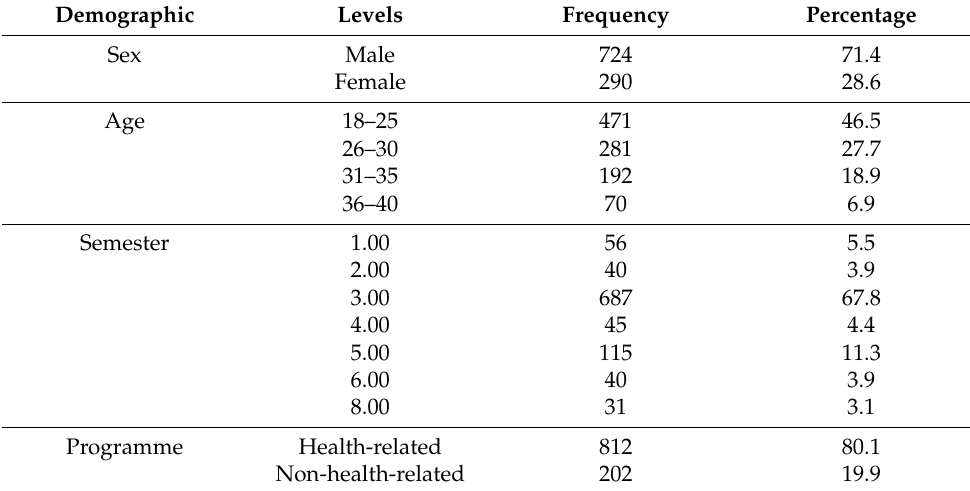
Table 1. Demographic Characteristics of